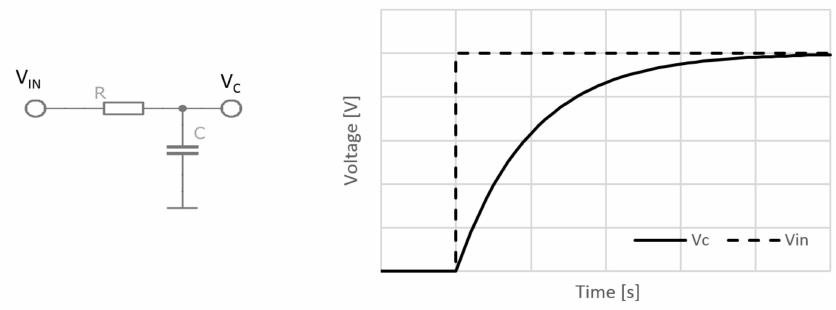
Figure 2. Resistor–capacitor (RC) circuit diagram and working